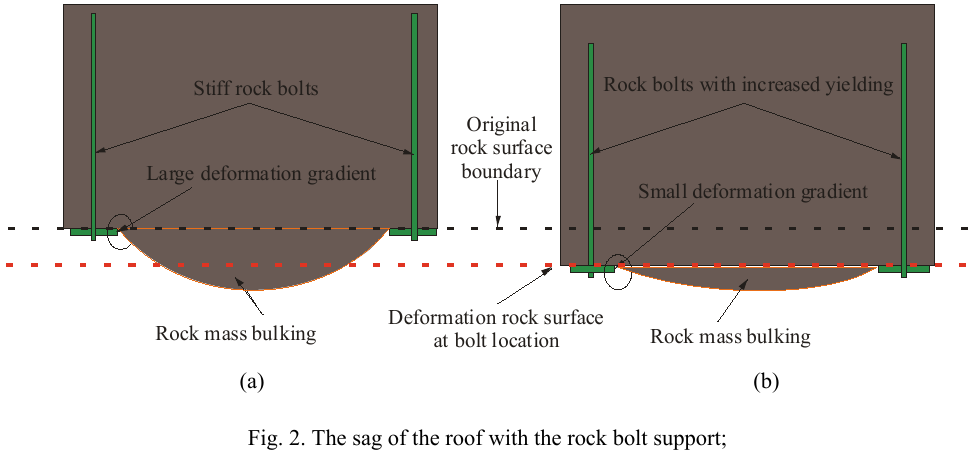
Fig. 2. The sag of the roof with the rock bolt support; (a) without increased deformability, (b) with increased deformability (based on